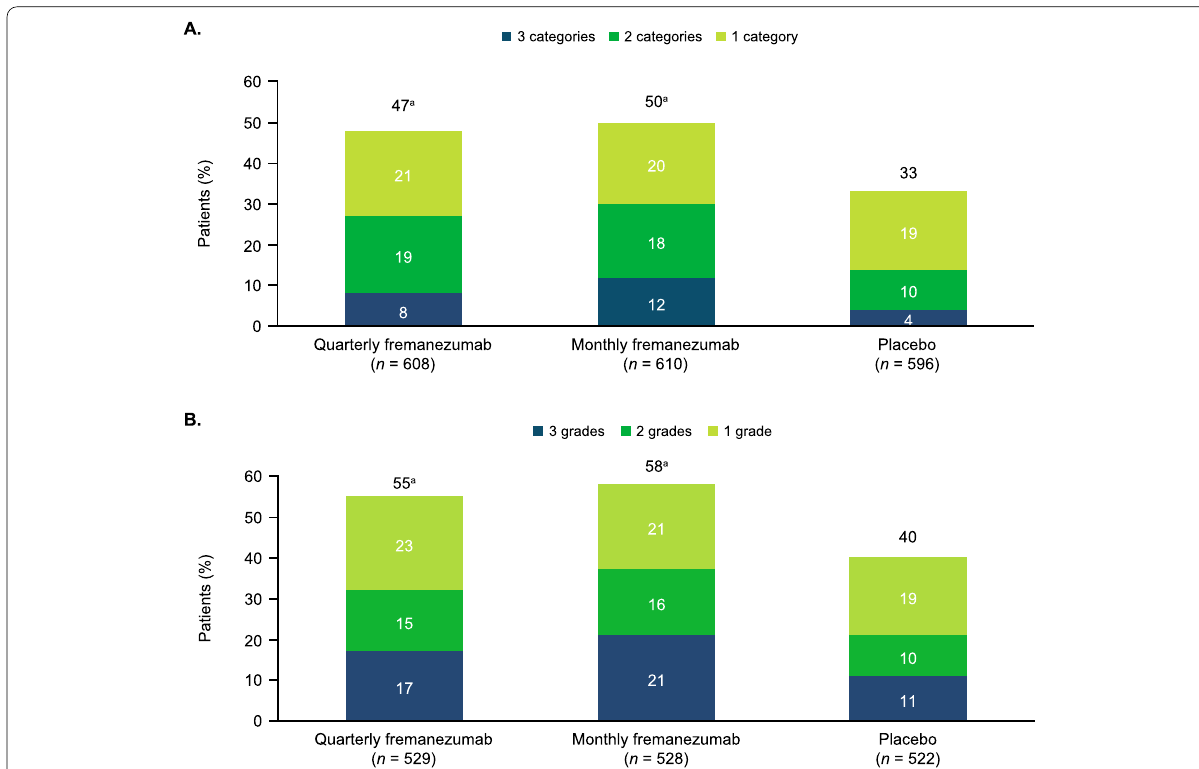
Fig. 3 Proportion of patients experiencing downward shifts in A ) HIT-6 severity categories and B ) MIDAS severity grades during 12 weeks of treatment. HIT-6, 6-item Headache Impact Test; MIDAS, Migraine Disability Assessment. n values shown are the number of patients with data available for analysis of shift in disability severity category in HIT-6 or MIDAS scores at the end of treatment. Total proportion of patients with a downward shift of 1, 2, or 3 categories or grades (as shown at the top of each bar) may differ from the sum of the proportions of patients with downward shifts of 1, 2, or 3 categories or grades due to rounding. a P < 0.0001 versus